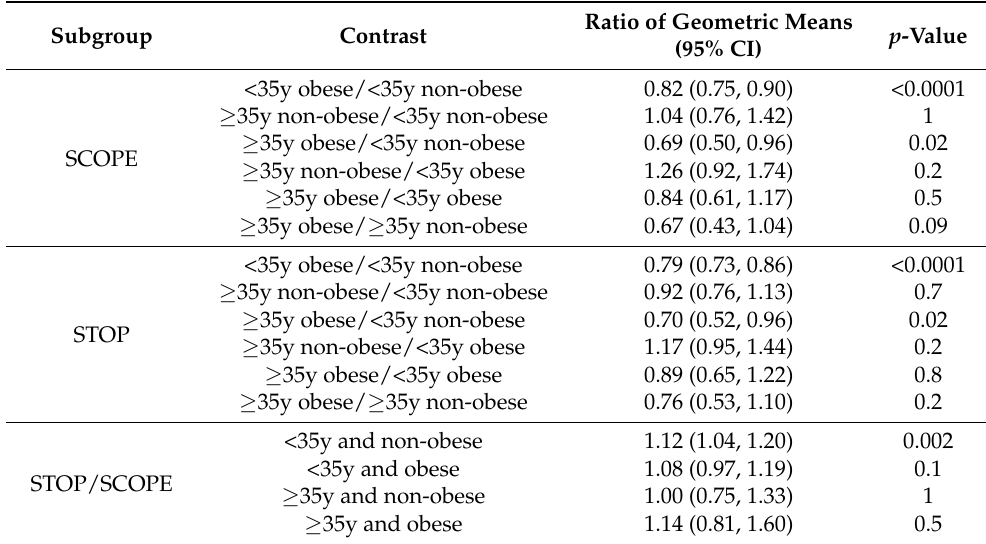
Table 8. Post hoc comparisons for human placental lactogen (hPL) in different maternal age and BMI categories within SCOPE and STOP and between different maternal age and BMI categories between SCOPE and STOP.